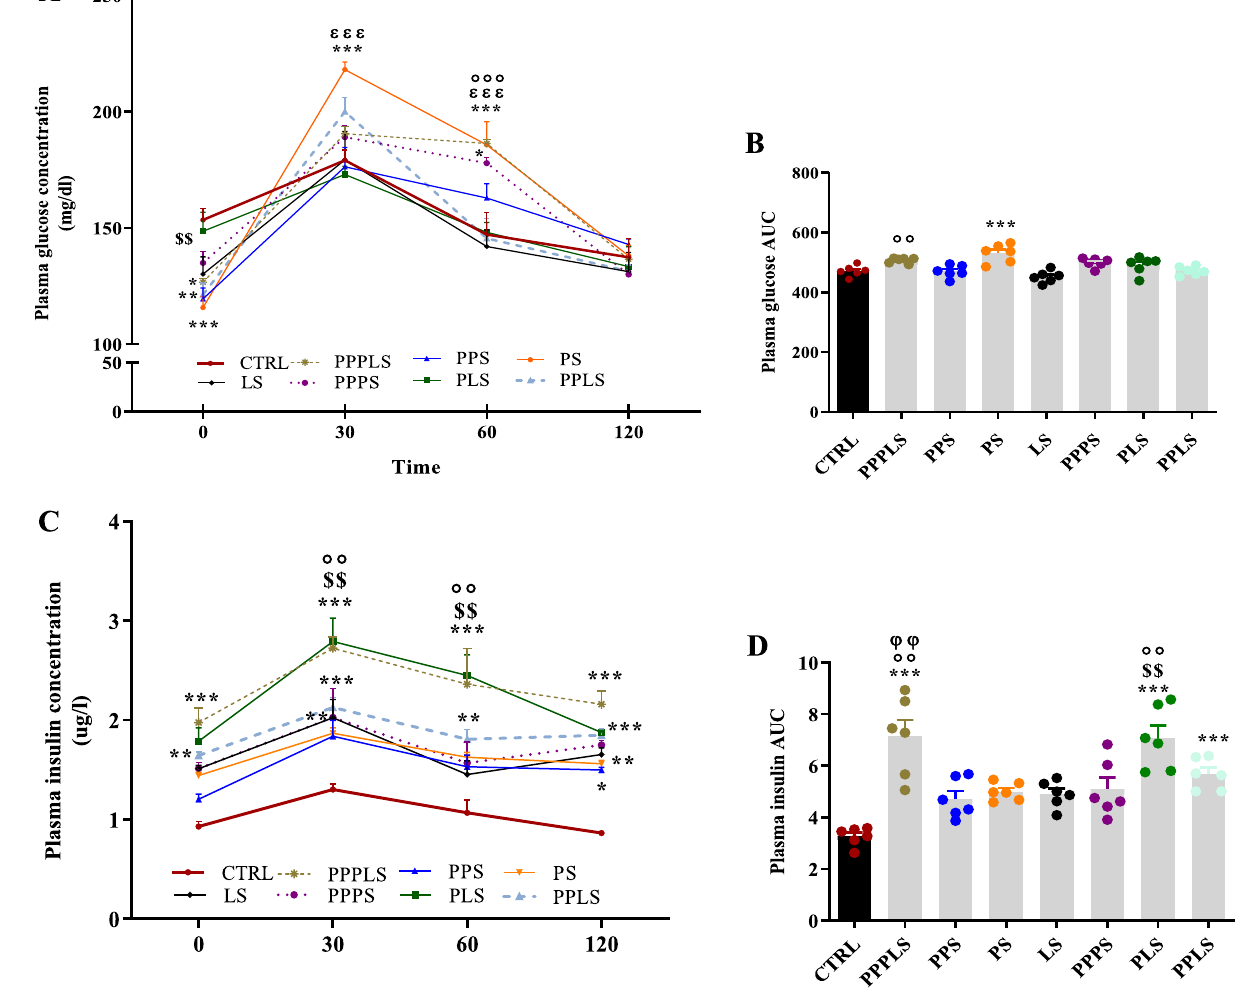
Figure 2. Effect of perinatal stress on plasma glucose level ( A ) and AUC ( B ), plasma insulin level ( C ) and AUC ( D ) during OGTT in young adult male offspring. Each point and column represent mean ± SEM (n = 6 rats/ group, 6 litters/group); Data was analyzed using two-way repeated measures ANOVA followed by Tukey’s post hoc test; * P < 0.05, ** P < 0.01, *** P < 0.001 versus CTRL group; $$ P < 0.01 versus PS group; οο P < 0.01, οοο P < 0.001 versus LS group; φφ P < 0.01 versus PPPS group; ɛɛɛ P < 0.001 versus PLS group. CTRL non stress, PPPLS pre- pregnancy, pregnancy, lactation stress, PPS pre-pregnancy stress, PS pregnancy stress, LS lactation stress, PPPS pre-pregnancy, pregnancy stress, PLS pregnancy, lactation stress, PPLS pre-pregnancy, lactation